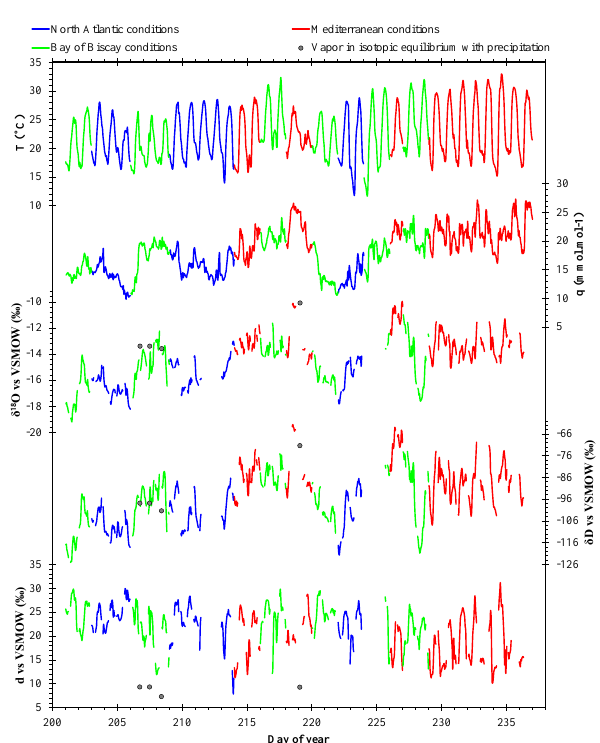
Figure 3. Hourly time series of air temperature ( T ), mixing ratio ( q ), δ 18 O, δ D, deuterium excess ( d ) from 20 July to 24 August 2011 at the experimental site according to air mass origin (see Fig. 1). Grey dots are δ v and d values calculated from the isotopic equilib- rium with